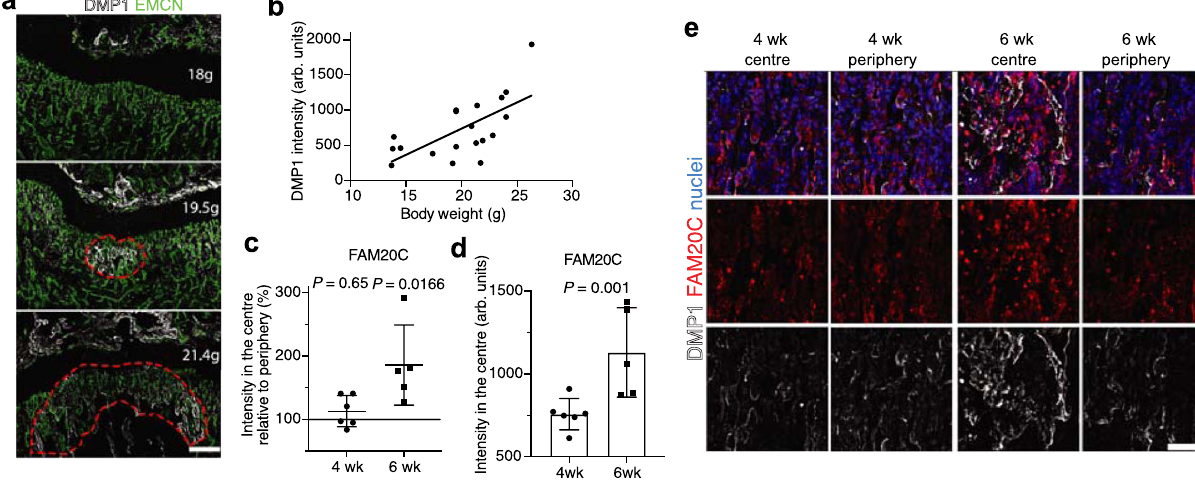
Fig. 4 DMP1 secretion correlates positively with body weight and coincides spatiotemporally with FAM20C upregulation. a DMP1 and EMCN immunostaining of 5.5-week-old femurs derived from littermate mice. Red dotted line marks the area of extracellular DMP1 at the OF. Scale bar 250 µ m. b Counterplot of body weight versus DMP1 intensity. R 2 = 0.4139, n = 19. c Quanti fi cation of FAM20C intensity in the centre relative to periphery (centre + periphery) in 4- and 6-week-old femurs. Two-tailed paired t -test. d Quanti fi cation of FAM20C intensity in the centre in 4- and 6-week-old femurs. Two-tailed paired t -test. c , d Pooled data from two independent experiments. At 4 weeks n = 6, 6 weeks n = 5. c , d Source data are provided in